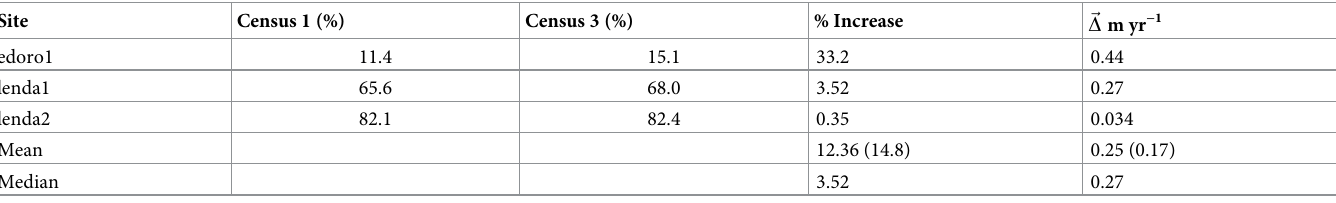
Table 1. Area-weighted mean radius of gyration measures for Gilbertiodendron -dominated forest patches.